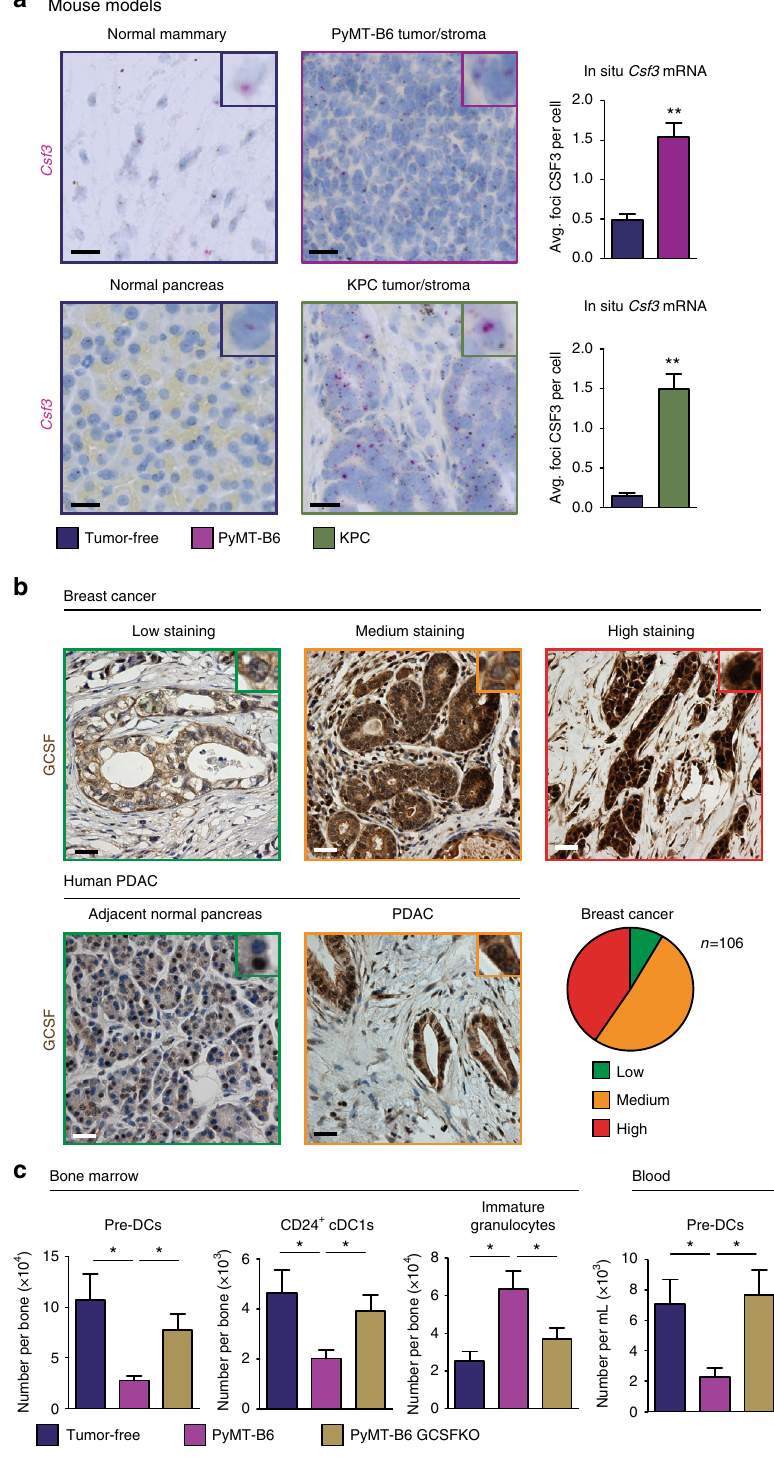
Fig. 5 Tumor-derived GCSF inhibits cDC1 development. a ISH for Csf3 on end-stage PyMT-B6 and KPC tumor tissue and tumor-free mammary or pancreas tissue; n = 3 per group. Scale bar 25 μ m. b Human patient BC and PDAC tumor tissue stained for GCSF. BC graded for low, medium, and high staining per tumor cell; BC, n = 106; PDAC, n = 5. Scale bar 10 μ m. c Number of BM pre-DCs, CD24 + cDC1s, and immature granulocytes and blood pre-DCs from mice bearing end-stage orthotopic PyMT-B6 or PyMT-B6 GCSFKO mammary tumors relative to tumor-free controls, n = 6/group. End stage for each model is de fi ned in the Methods. Error bars represent mean + / − s.e.m.; * p < 0.05, ** p < 0.01 by unpaired two-sided Student ’ s t